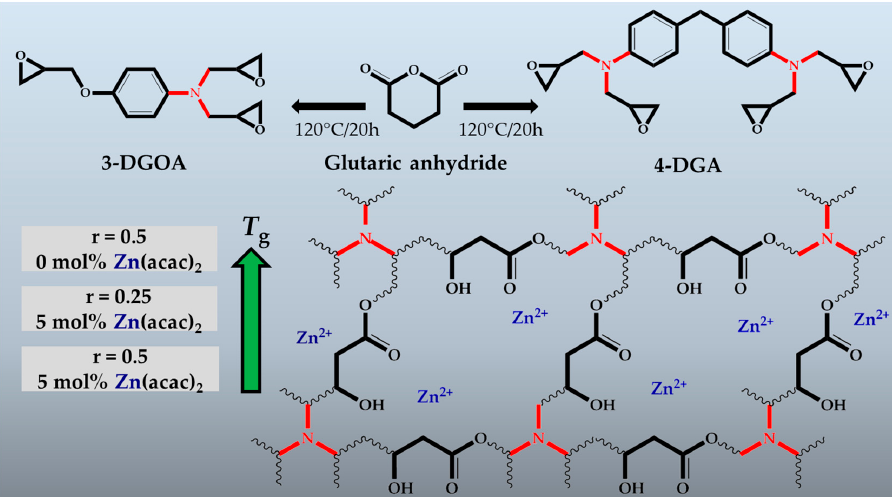
Figure 1. Epoxy-anhydride vitrimers obtained from 4,4 ′ -methylenebis( N , N -diglycidylaniline) (4-DGA) and N , N -diglycidyl-4-glycidyloxyaniline (3-DGOA) with varying glass transition temperature ( T g )